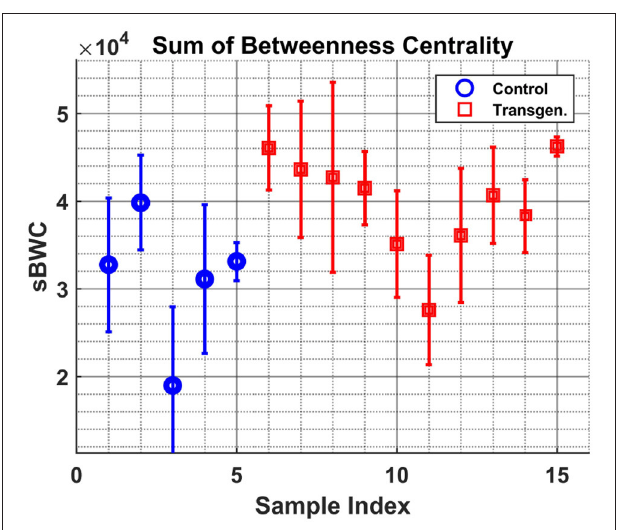
FIGURE 6 | Samples graph Molecular-Topological-Index. Similar to Figure 5 , but for the MTI